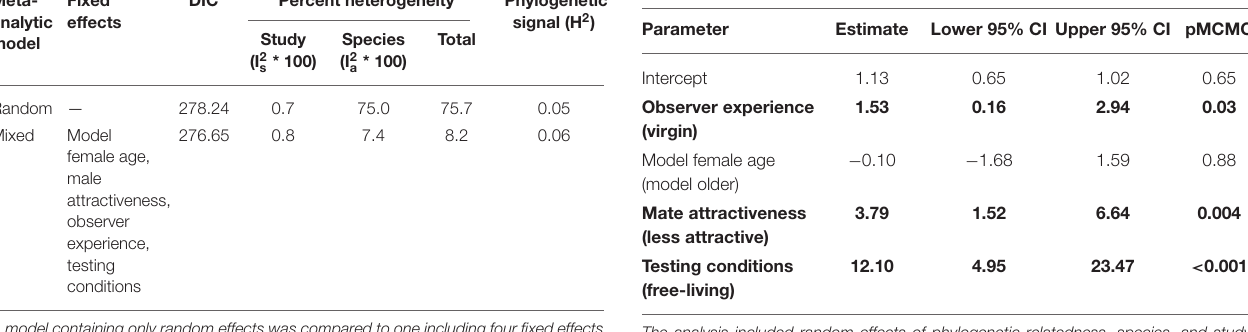
TABLE 2 | Fixed-effect estimates from the Bayesian hierarchical meta-analysis assessing strength of moderators hypothesized to affect the occurrence of mate-choice